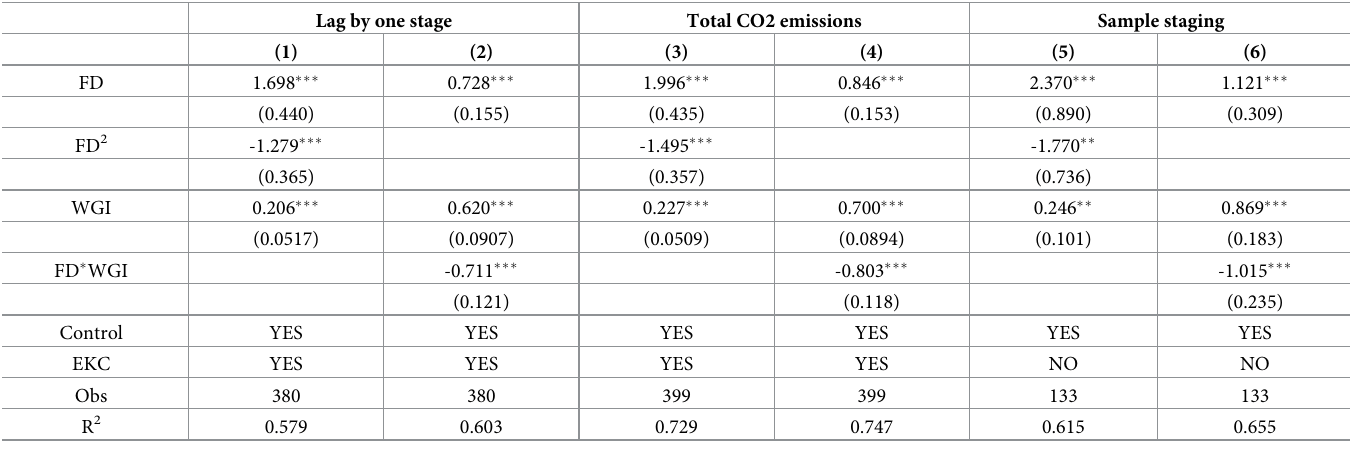
Table 4. Robustness